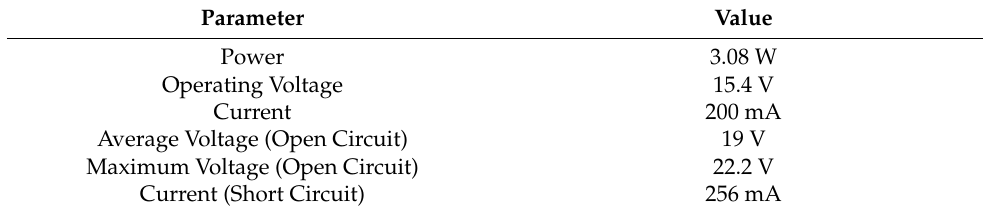
Table 2. Properties of PT15-300 thin film solar cell